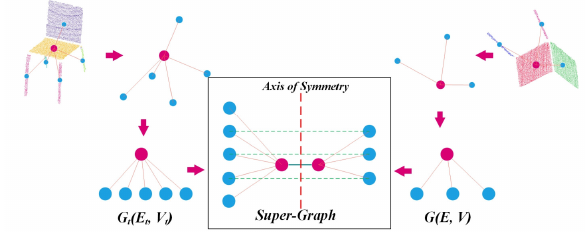
Figure 3. The schematic diagram of the